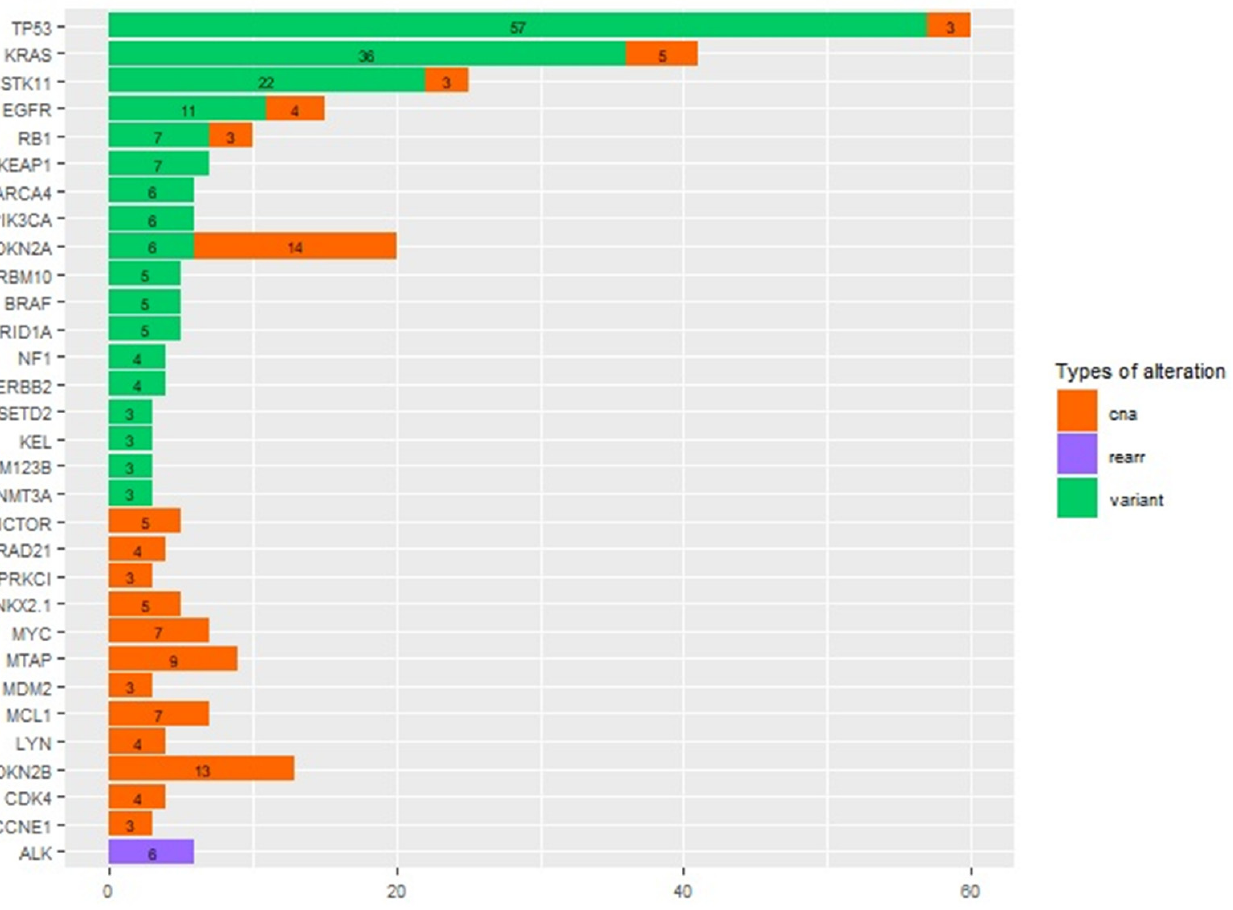
Figure 3. Number of patients with alterations in different genes, with specified the type of alteration for each gene.